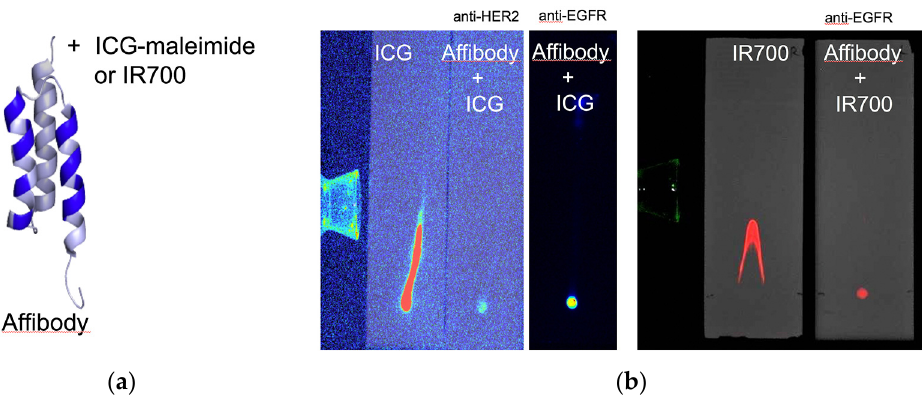
Figure 7. Affibody molecules are shown with randomized positions in the binding site, which are indicated in blue. The molecule was labeled with ICG maleimide or IRDye 700. The figure was adopted from Wallberg H, et al. [46] ( a ). Thin-layer chromatography (TLC) showed that the fluorescence droplet spots of ICG-conjugated anti-EGFR, anti-HER2 affibody, and IR700-conjugated anti-EGFR affibody (2 µ L) stayed at the starting point; in contrast, free ICG and free IR700 ran on the slides ( b ).